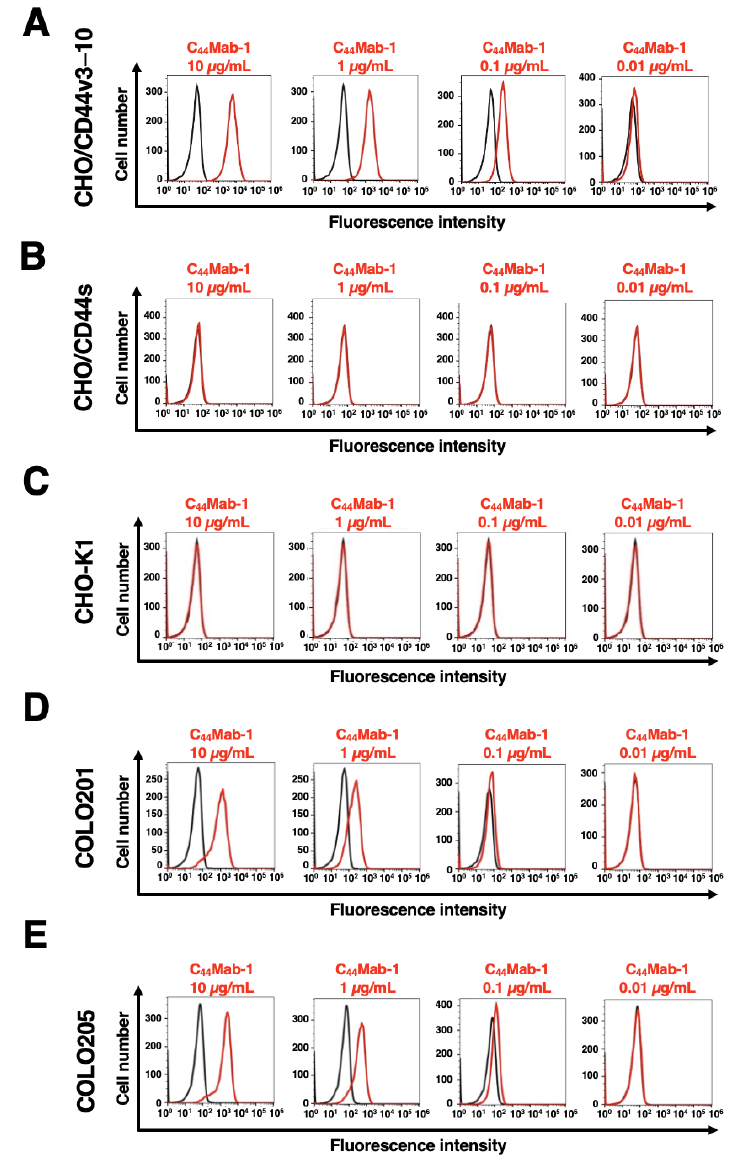
Figure 2. Flow cytometry using C 44 Mab-1. CHO/CD44v3 – 10 ( A ), CHO/CD44s ( B ), CHO-K1 ( C ), COLO201 ( D ), and COLO205 ( E ) were treated with 0.01 – 10 µg/mL of C 44 Mab-1, followed by treatment with Alexa Fluor 488-conjugated anti-mouse IgG (Red line). The black line represents the negative control (blocking buffer).